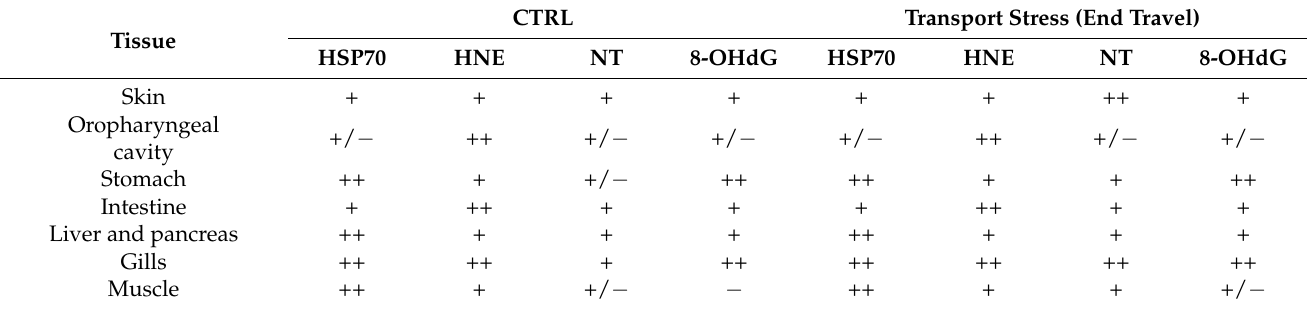
Table 2. Immunohistochemical localization of heat shock protein 70 (HSP70), 4-hydroxy-2-nonenal (HNE), nitrotyrosine (NT) and 8-hydroxy-2’-deoxyguanosine (8-OHdG) in different tissues of meagre (transported and control animals): − , not detectable; +/ − , slight but above background levels; +, moderate staining; ++, marked staining.